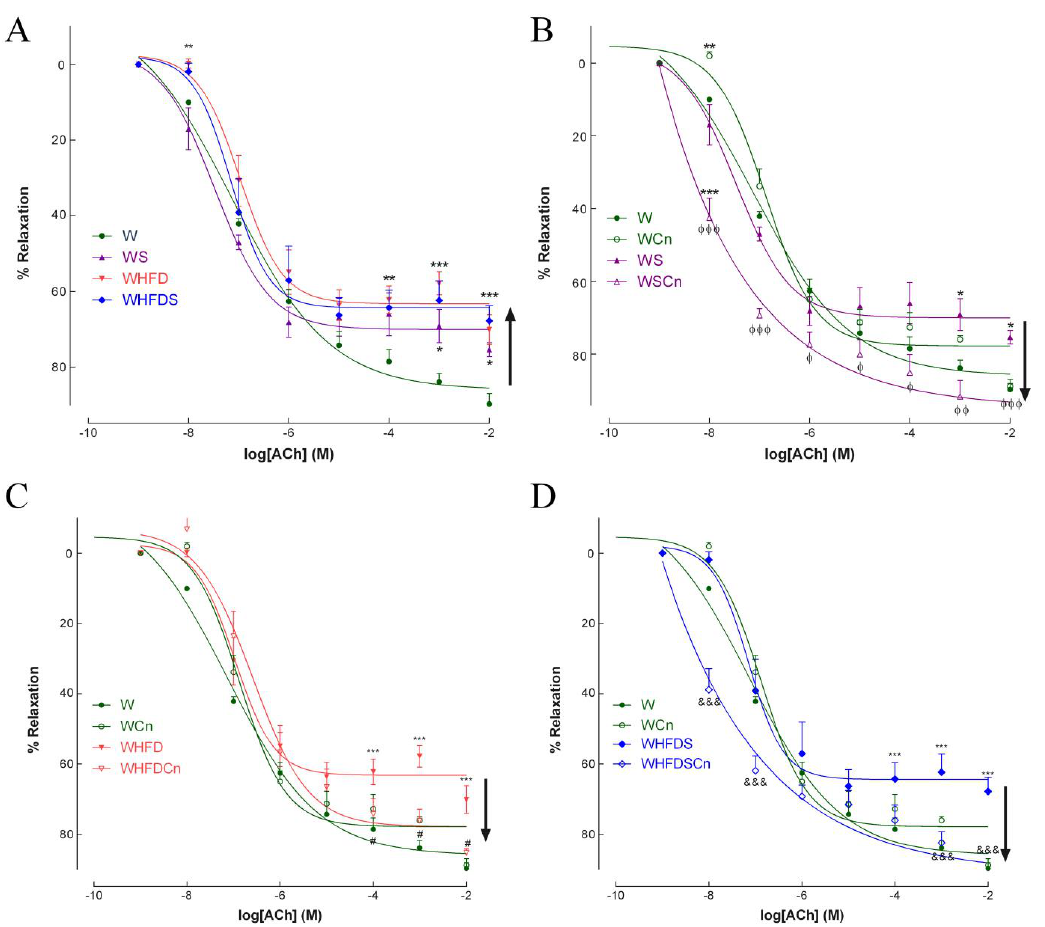
Figure 2. Effects of cinnamaldehyde (Cn) treatment on vasodilatory responses to acetylcholine in aortas of 8-months-old Wistar (W, A ) rats fed with sucrose (WS, B ), high-fat diet (WHFD, C ) or both (WHFDS, D ), compared to normal W rats. Data are expressed as mean ± SE (n = 12 animals per group). * p < 0.05, ** p < 0.01, *** p < 0.001 vs. W rats; ϕ p < 0.05, ϕϕ p < 0.01, ϕϕϕ p < 0.001 vs. WS rats; # p < 0.05 vs. WHFD rats; &&& p < 0.001 vs. WHFDS rats.